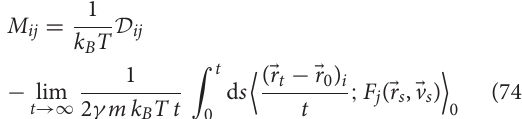
spatially periodic force field F which adds vortices in its rotational E component, e.g., a lattice of convective cells as in Figure 7 . ξ t is standard Gaussian white The vector E